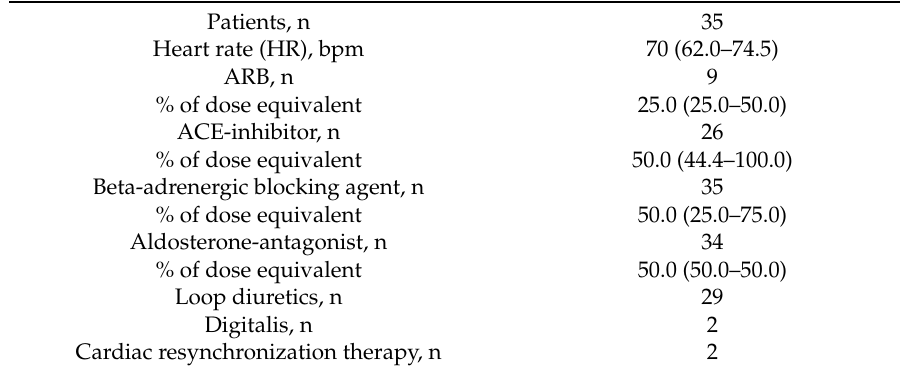
Table 3. Pharmacological HF treatment at initiation of immunoadsorption and % of dose equivalent of each